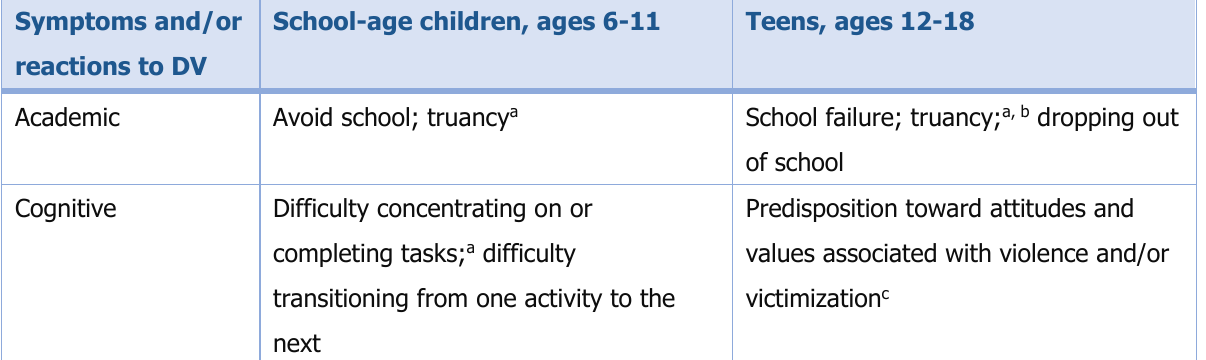
Table 1. Symptoms of Exposure to DV in Youth of Different Ages and Developmental